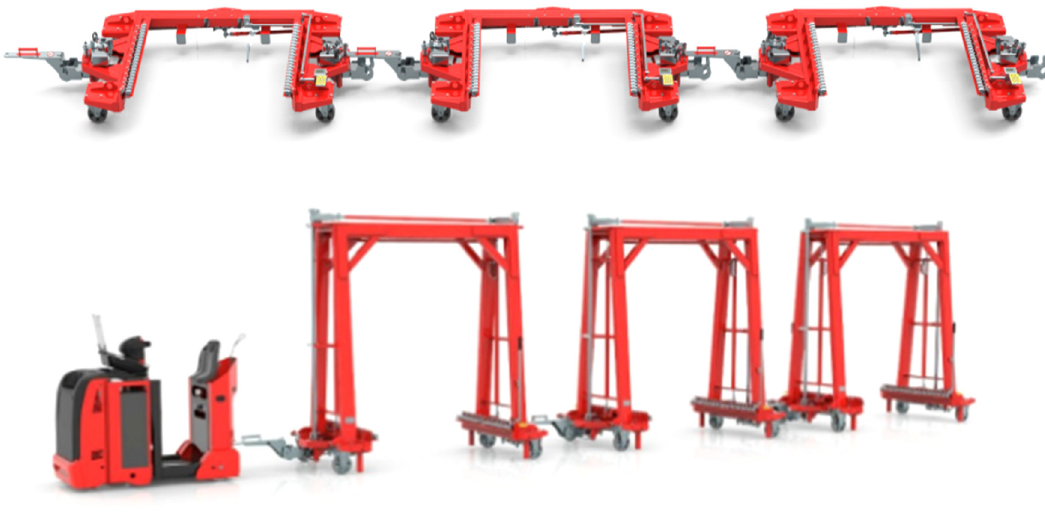
Figure 3: Examples of standardized systems used in internal logistics [ 17,18 ] .